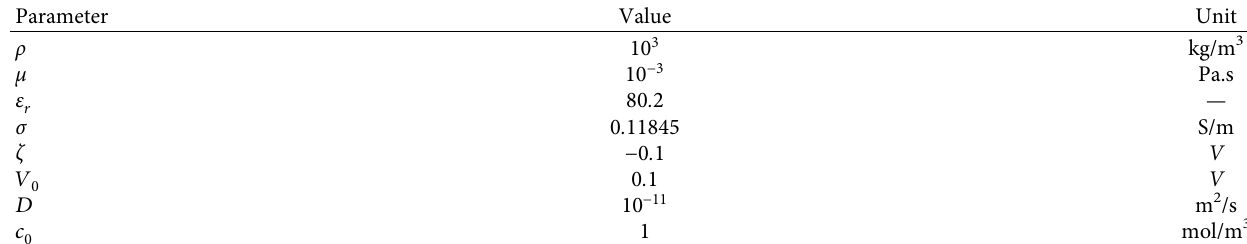
Table 1: Values of used variables in this